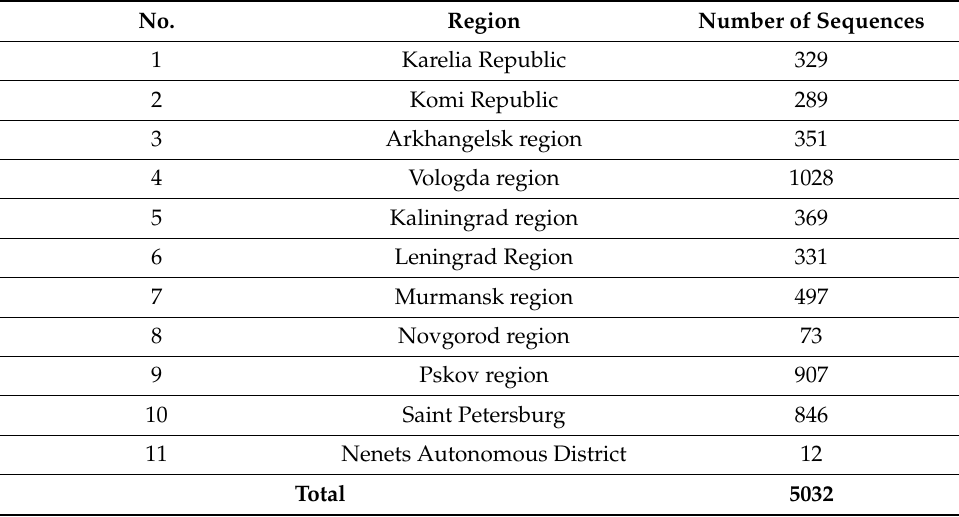
Table 1. Number and origin of sequences used in the